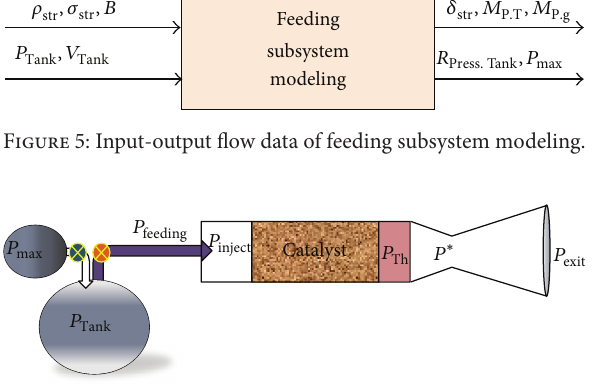
Figure 6: Introducing pressure of different propulsion system parts.